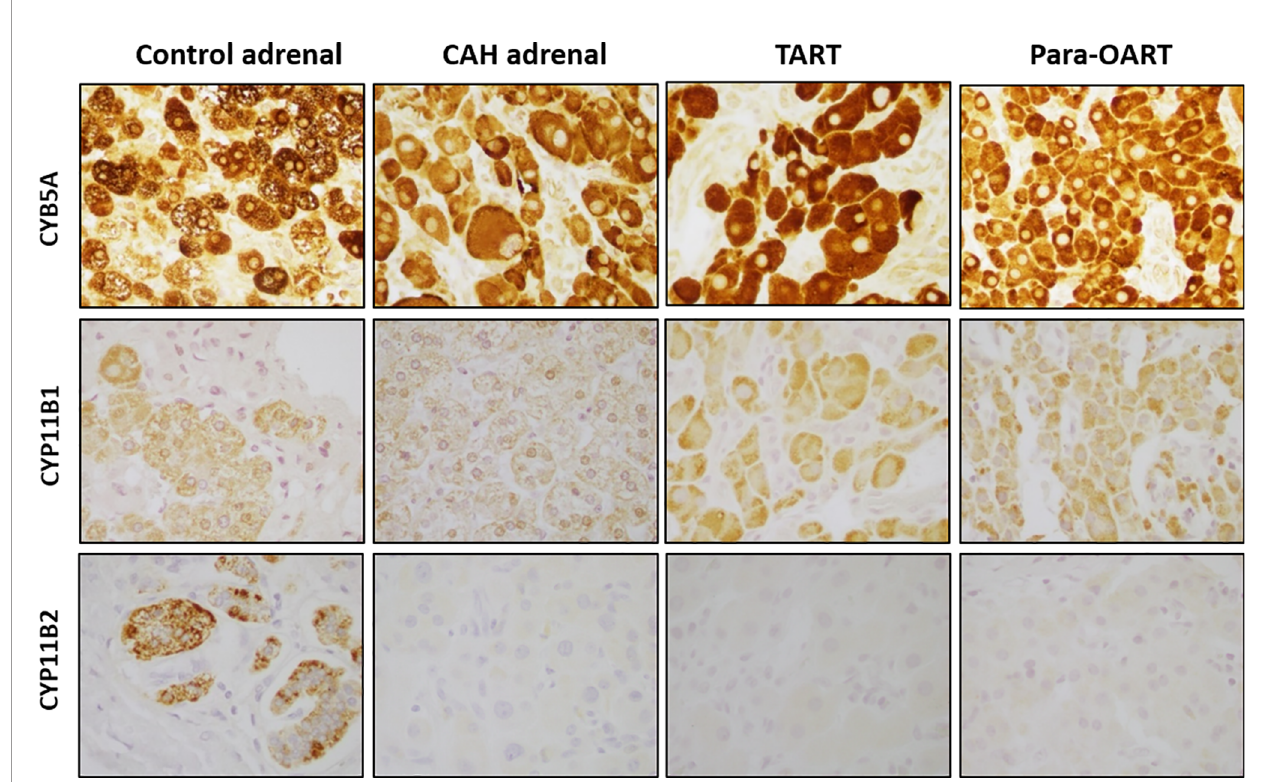
FIGURE 2 | Steroidogenic immunolabeling in control and CAH adrenals,TART and para-OART. Immunohistochemical staining of control adrenal shows positive staining for all three zone-characteristic proteins. ART and representative CAH adrenals display strong staining of zona reticularis-characteristic CYB5A, a marker of androgen production, positive staining but less presence of CYP11B1, and negative staining for CYP11B2 proteins. Two of fi ve CAH adrenals had minimal CYP11B2 staining (not shown). Interstitial/vascular spaces with fi broblasts, vessels and other structures are negatively stained. (Original magni fi cation